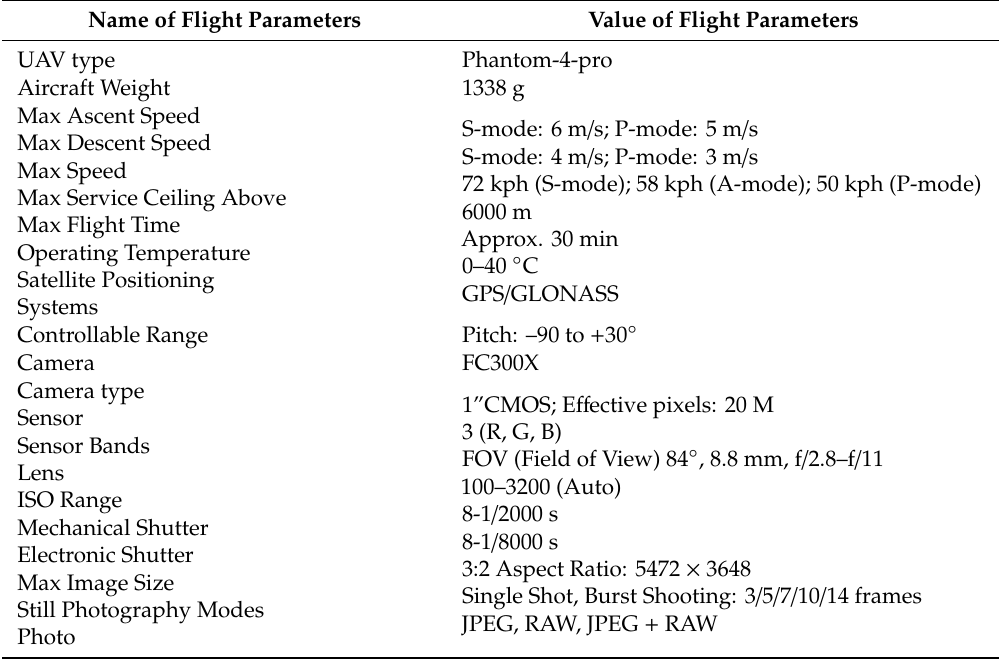
Table 3. Specifications of the aerial remote sensing data and the UAV platform used in this